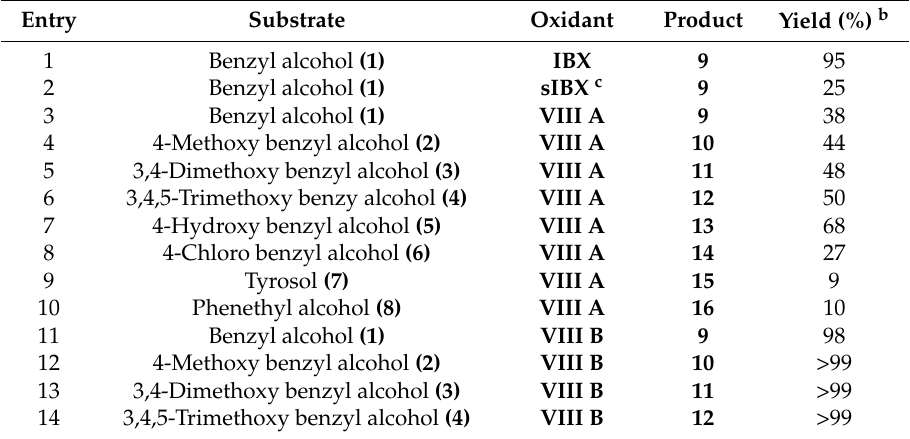
Table 5. Oxidation of compounds 1 – 8 with VIII A–C a